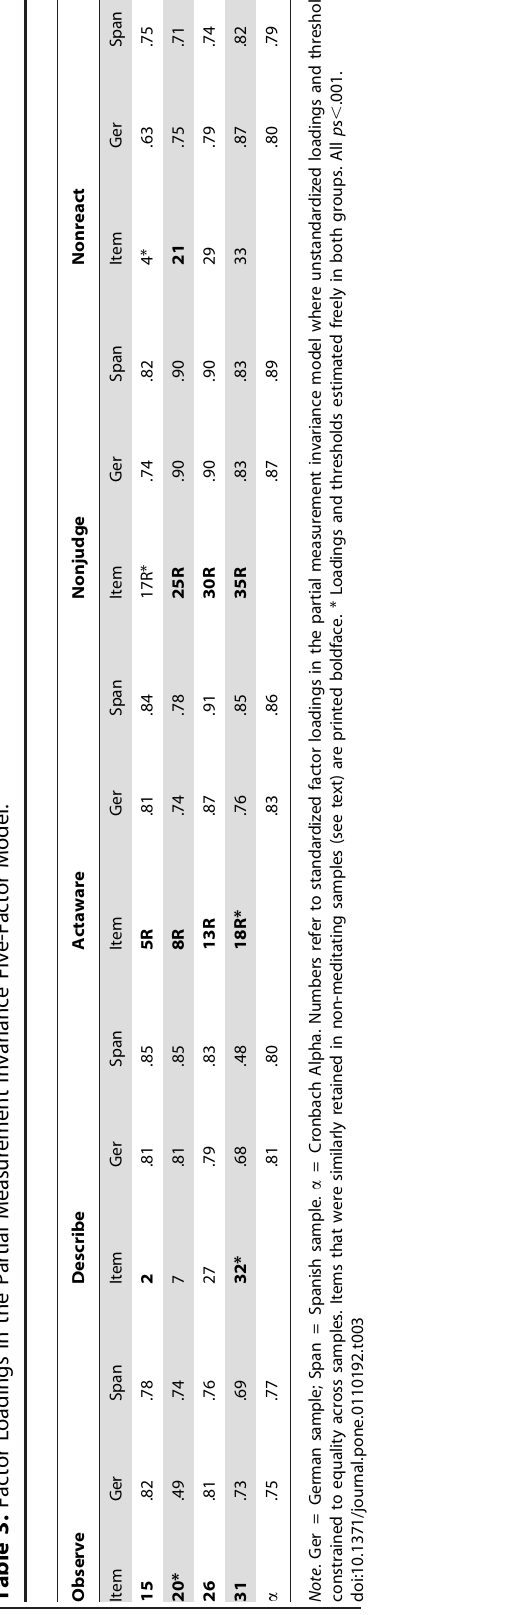
Figure 2. Orientation to Experience was, again, a slightly stronger predictor of all facets of perceived stress save Joy than Self- regulated Attention, corroborating the pattern obtained before with regard to depression and anxiety. Overall, the model explained 36% to 38% of the variance of Worries, Tension, and Joy scores, respectively, and 16% of the Demands score variance. on the former three scores was around.18 each ( p s , .001) and.12 ( p , .001) on Demands